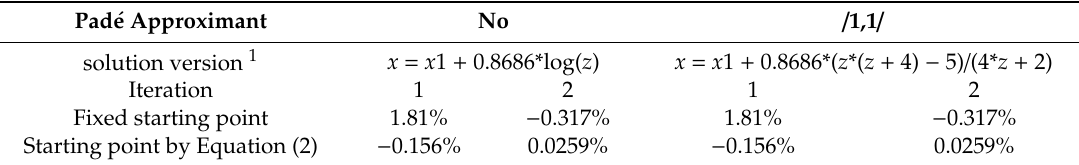
Table 1. Comparison of maximal relative error (in %) for the first and second iteration without the Padé approximant and with a Padé approximant of the order /1,1/ for the Reynolds number Re from 4000 to 10 8 .